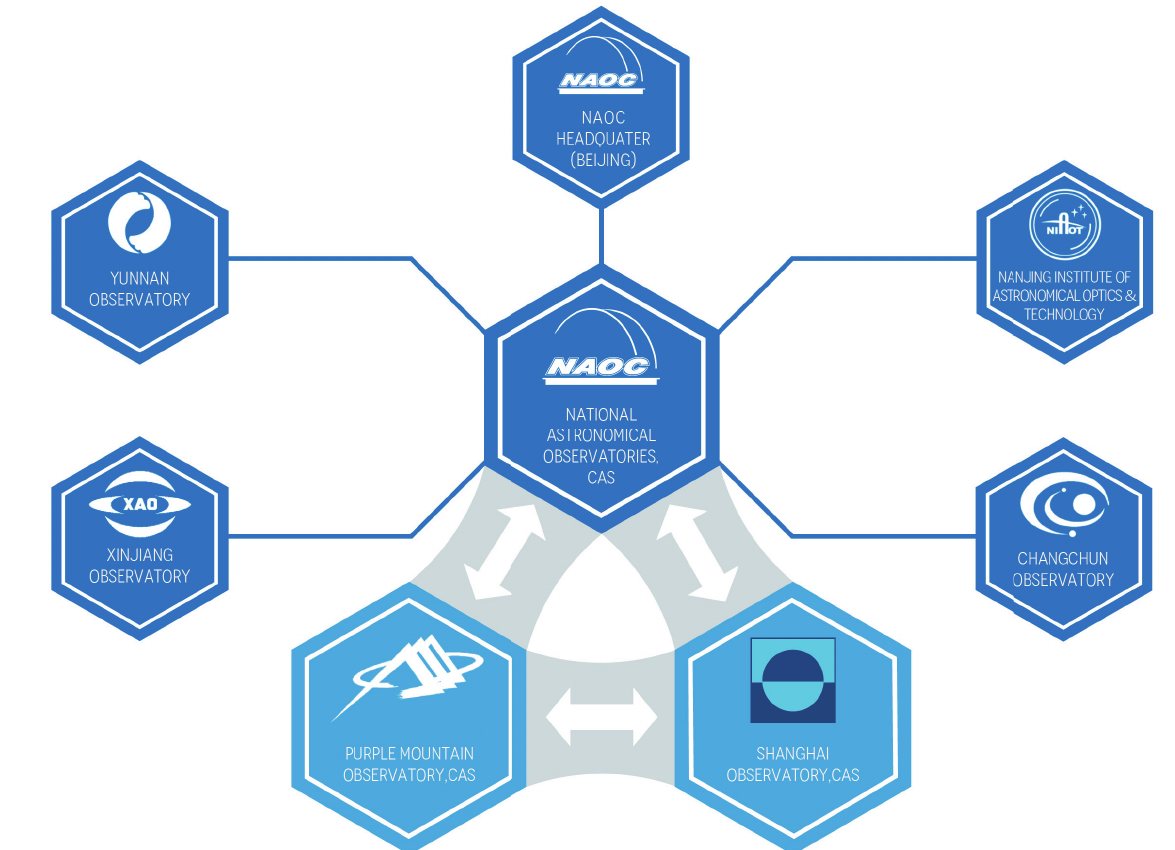
Figure 1. The Chinese Academy of Sciences (CAS) National Astronomical Observatories system. The Ministry of Education (Universities) system is not shown here as we do not yet have up-to-date